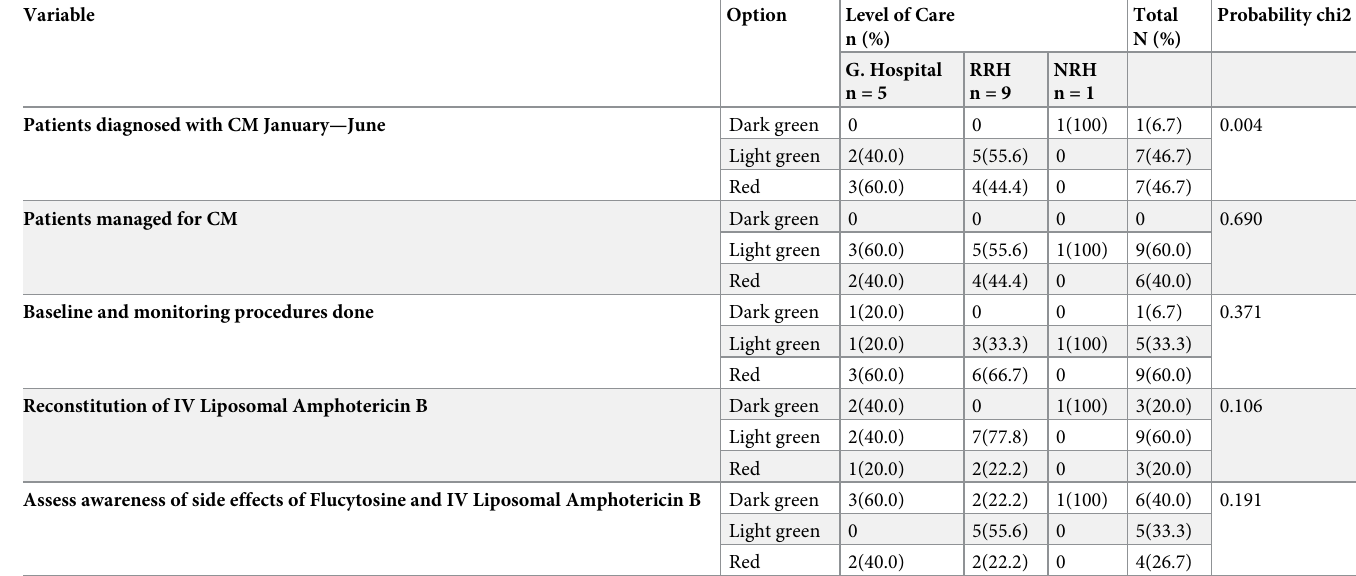
Table 3. Standards of care and management of HIV patients with CrAg+ and confirmed CM